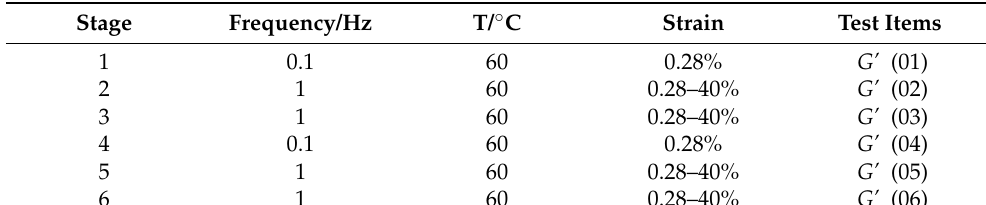
Table 4. Testing method.